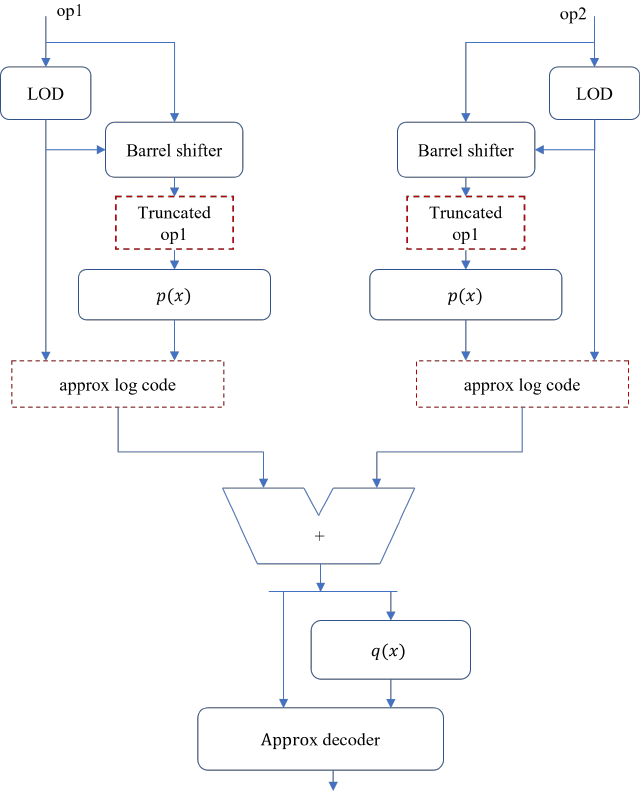
Figure 5. Pwl-Mit algorithm approximate multiplier top level hardware